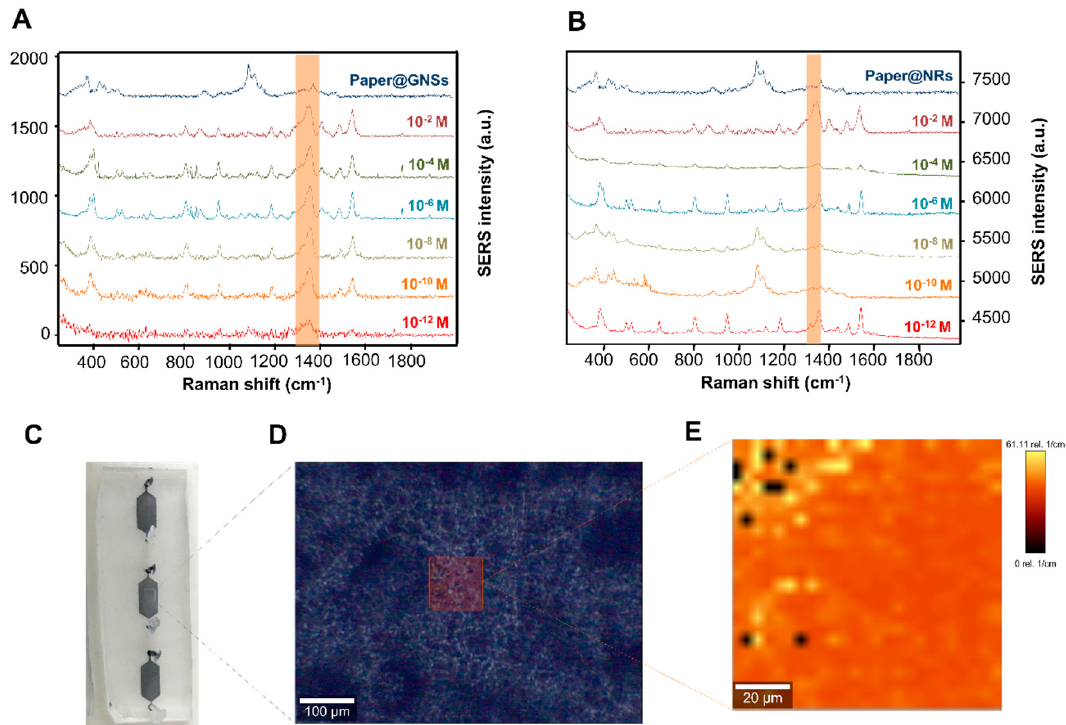
Figure 5. Results of the characterisation of the SERS substrates with the Raman model molecule 1NAT: SERS spectra of different concentrations of 1NAT on the surface of the SERS-paper substrate assembled with GNSs ( A ); SERS spectra of different concentrations of 1NAT on the surface of the SERS-paper substrate assembled with Au@AgNRs ( B ); photograph of the final assembled NPs after injection of the Raman model molecule ( C ); bright field image at 5× magnification of the self-assembled GNSs on the paper substrate ( D ); mapping obtained by plotting the SERS intensity of the characteristic band of the 1NAT at 1368 cm − 1 ( E ) in the area marked by the orange square in ( D ) for the GNSs substrates.